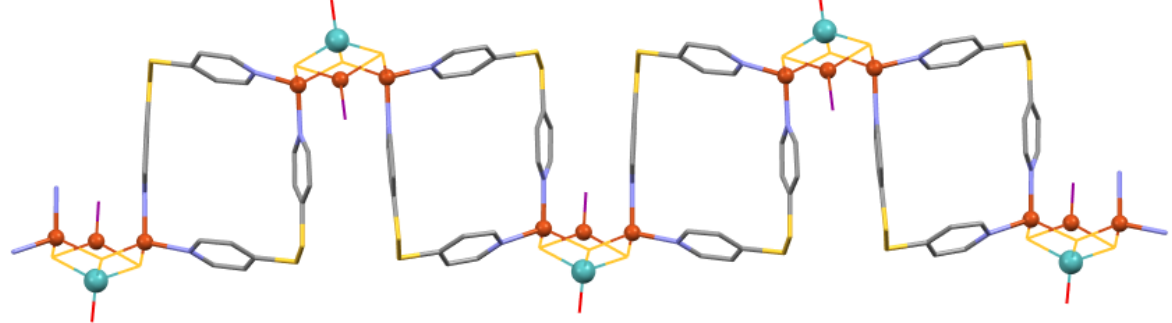
Figure 27. Coordination polymer strand in [MoOS (KEXDOH), formed from nido -like MoOS of opposite